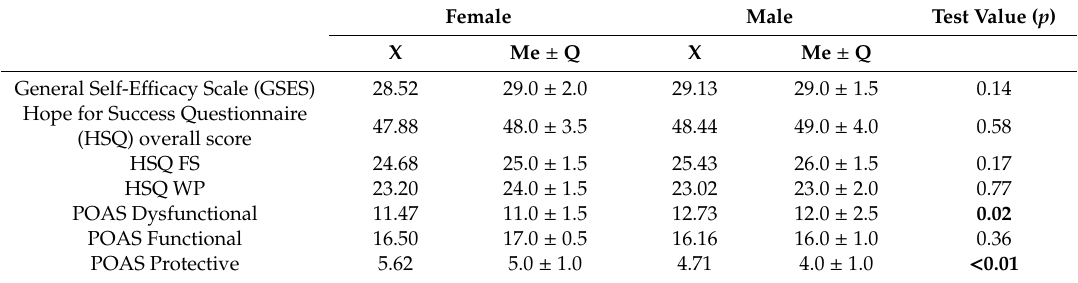
Table 1. Di ff erences between male and female participants before the intervention (n =